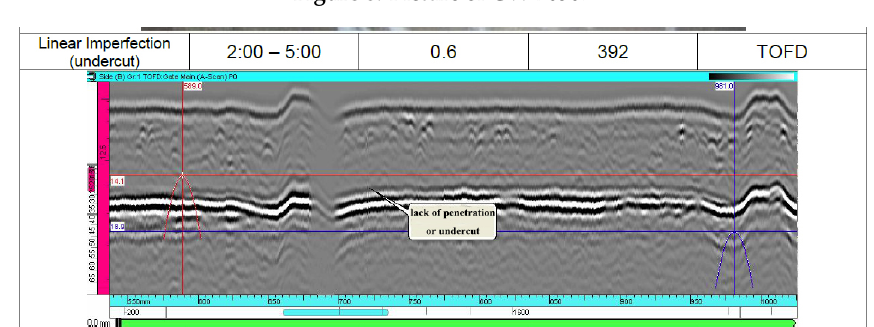
Figure 9. TOFD (Time of Flight Di ff raction) of GW